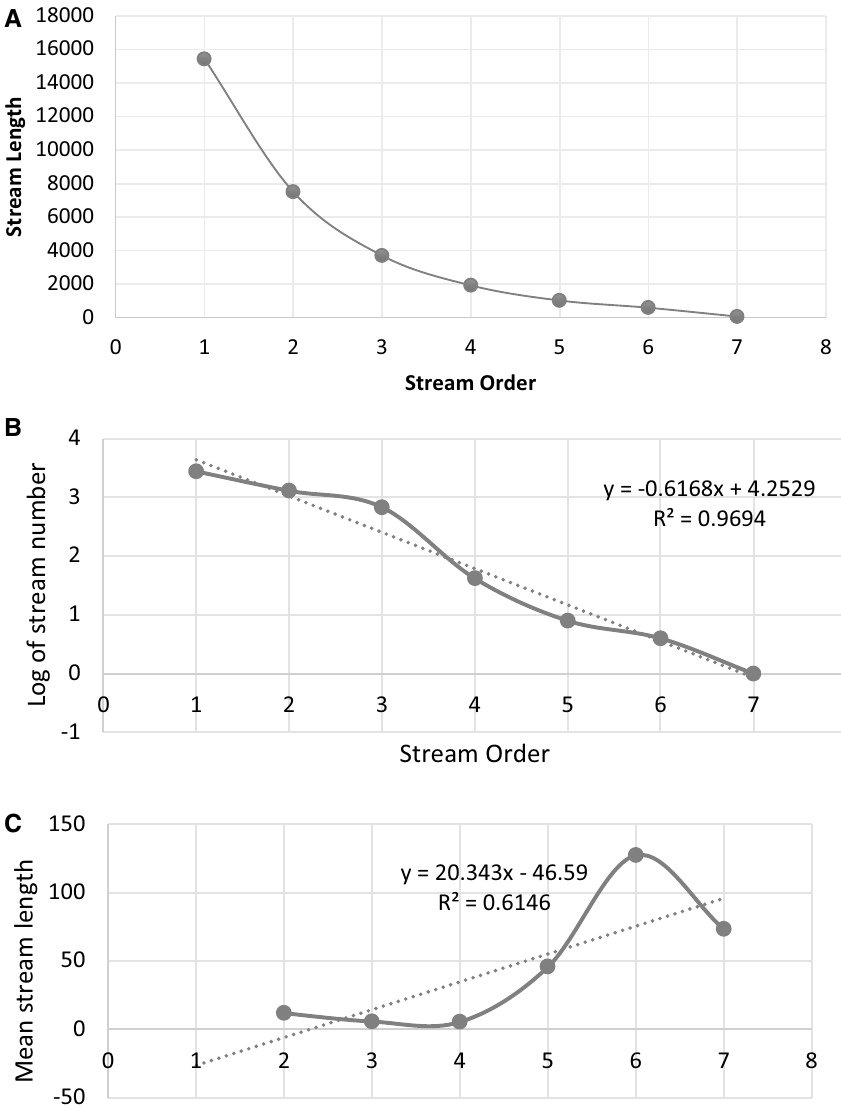
Fig. 5 a Stream length vs stream order, b Log of stream number vs stream order, c Mean stream length vs stream